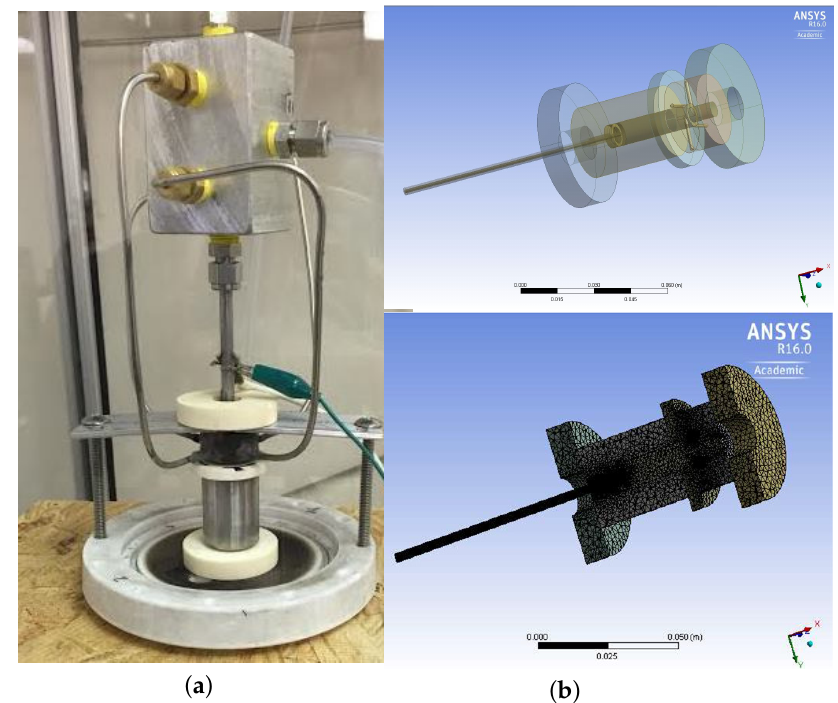
Figure 8. ( a ) The modified cold plasma chamber setup; and ( b ) geometry and meshed model in ANSYS